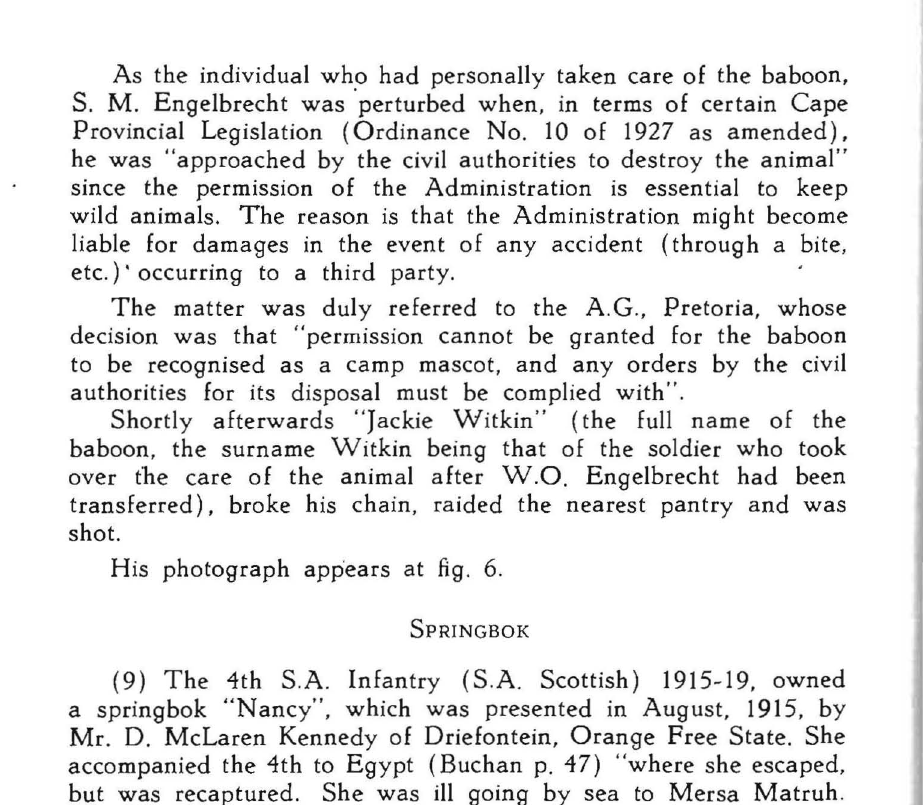
Fig. 7 . .. Nancy". Regimental Pet of S.A. Scottish 1915-1918